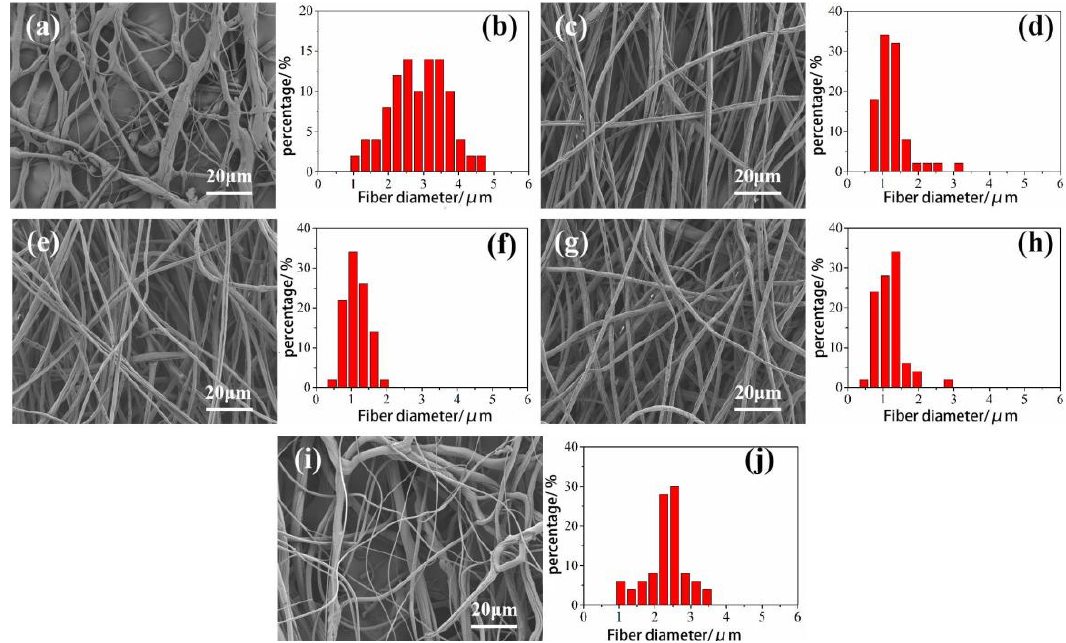
Figure 5. SEM images of fibers spun at different polymer concentrations and their corresponding diameter distribution. ( a – b ): 16 wt%; ( c , d ): 17 wt%; ( e , f ): 18 wt%; ( g , h ): 19 wt%; ( i , j ): 20 wt%.